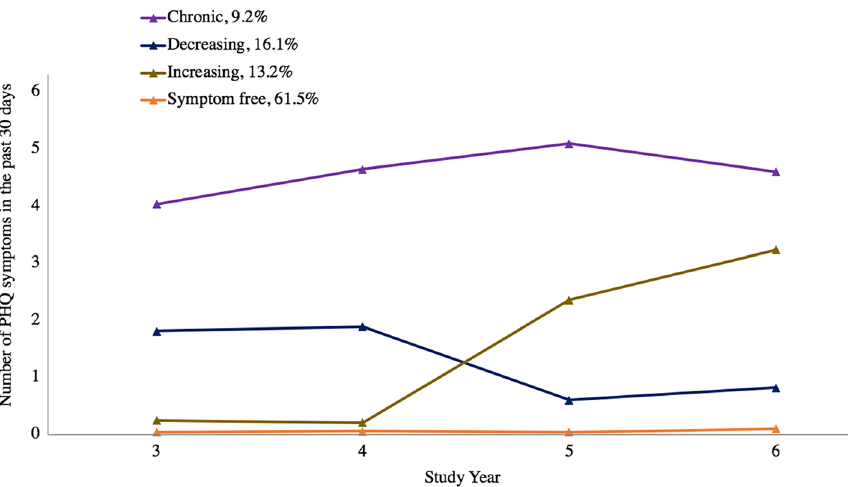
Figure 1. Latent trajectories for number of PHQ-9 depression symptoms in the past 30 days across four follow-up years, modeled using a zero-inflated Poisson distribution (n = 1844). PHQ = Patient Health Questionnaire (nine total